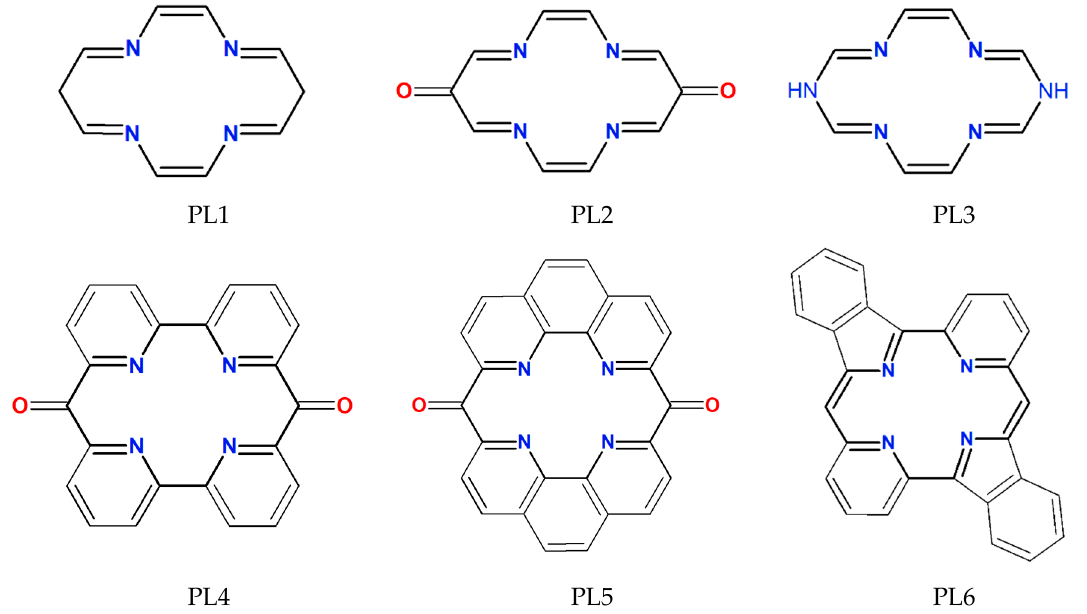
Figure 2. The chemical formulas of the proposed planar ligand (PL) structures for the octahedral coordinated metal-organic complexes.